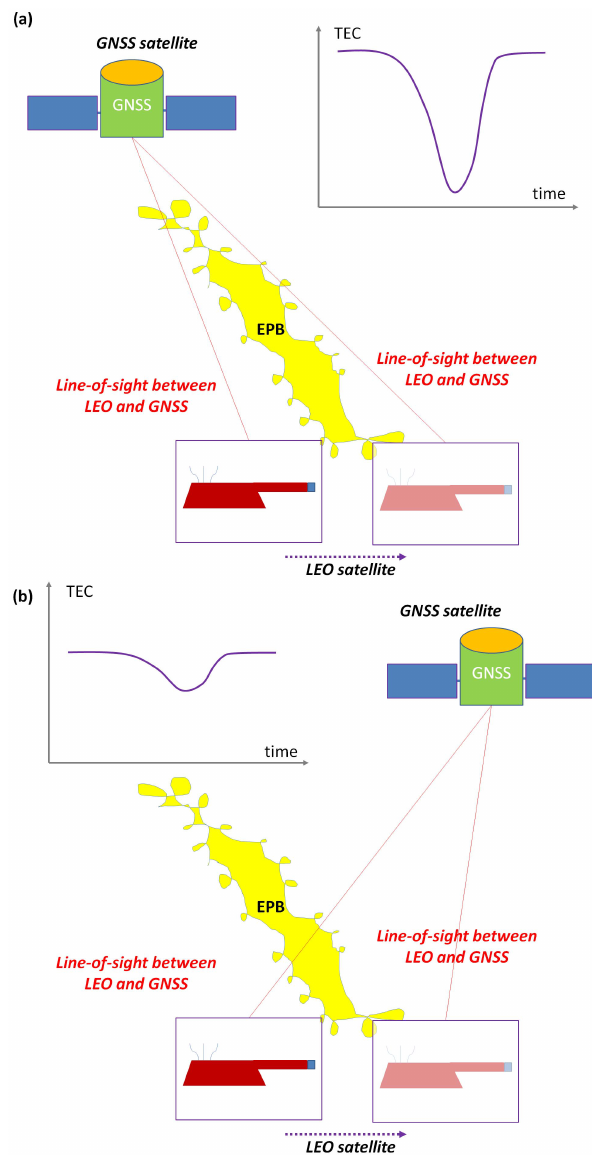
Figure 1. Schematic illustrations of the relationship between TEC fluctuation level and LOS direction between LEO and GNSS satel- lites: (a) the LOS and the EPB surfaces are nearly parallel, and (b) they are nearly